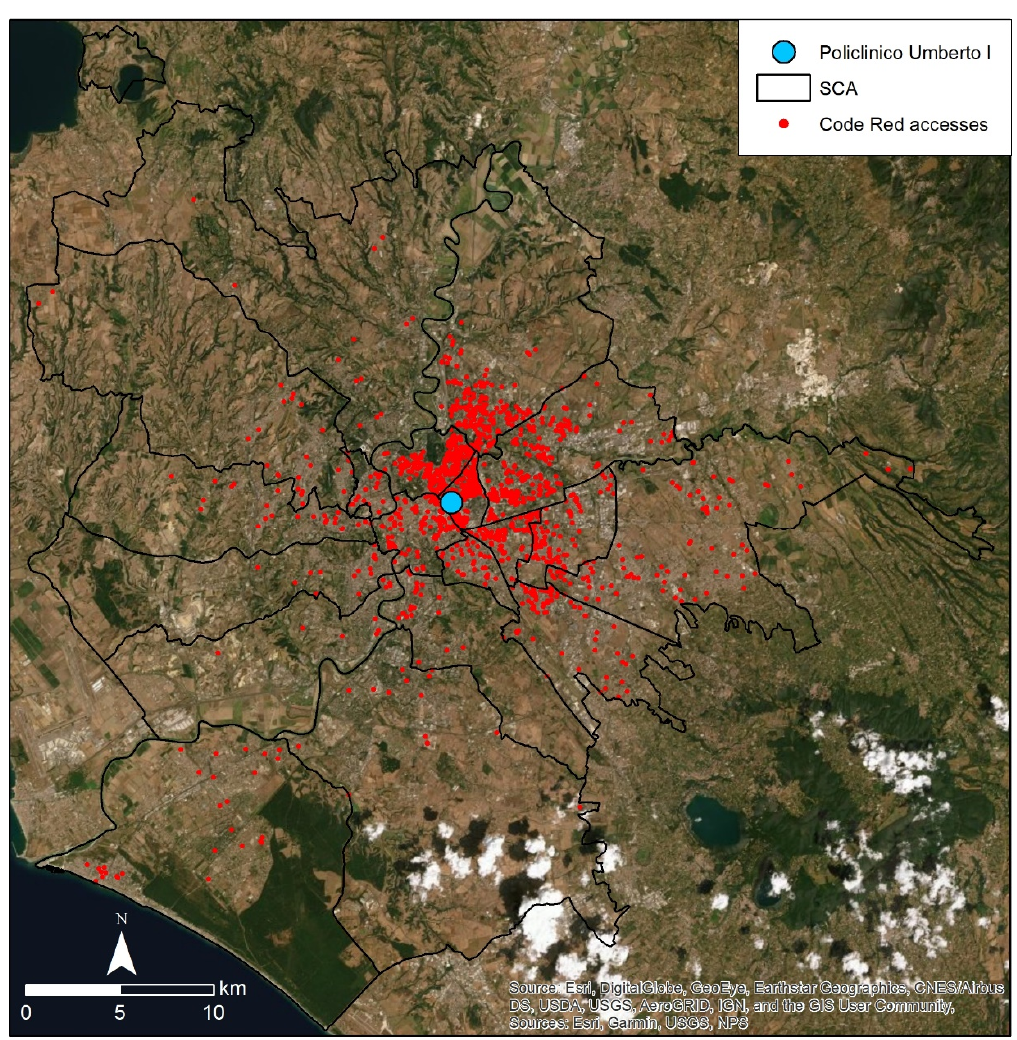
Figure 13. Dot map, elaborated by geocoding, concerning the accesses in code red recorded in 2011 by the Policlinico Umberto I emergency room. Source: authors’ elaboration.